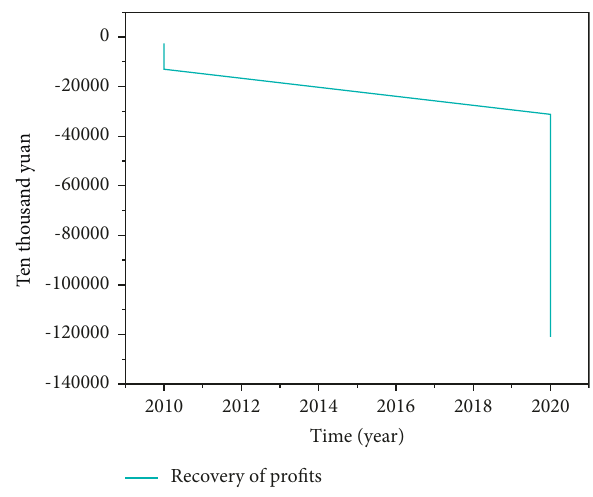
Figure 2: Waste plastic tray recycling profit.